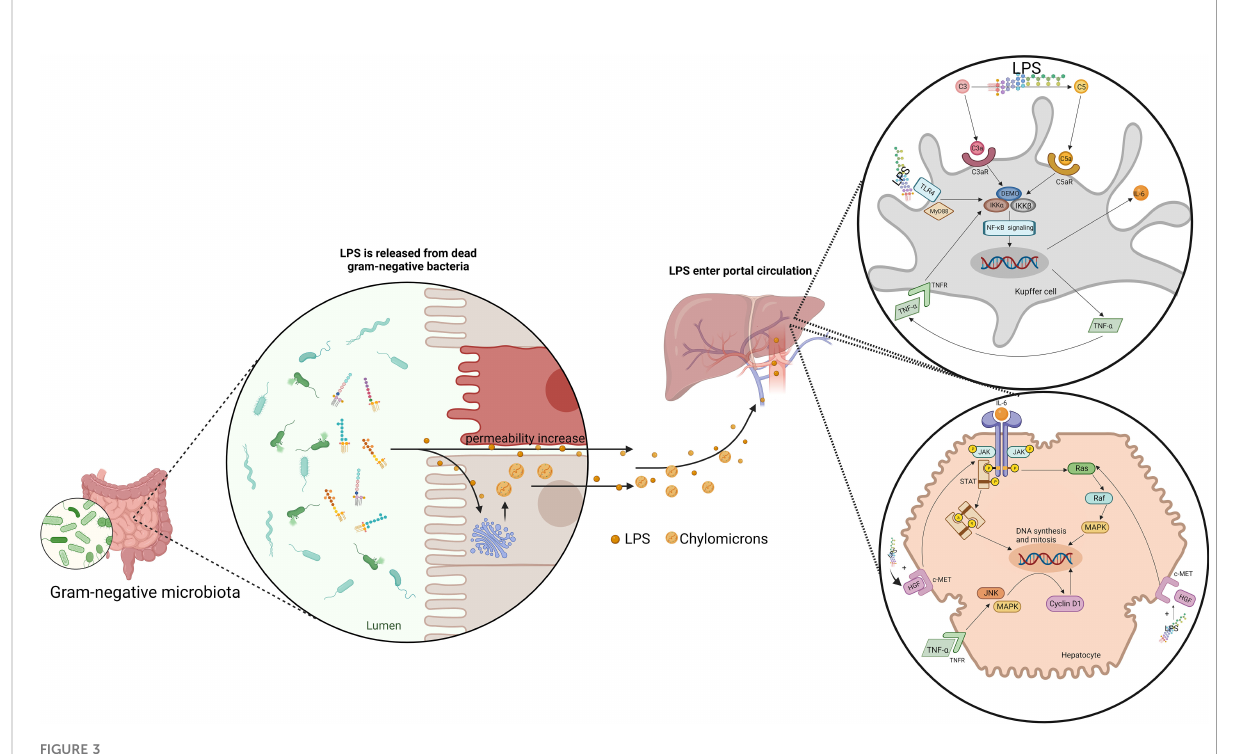
FIGURE 3 Gut-derived LPS translocates by chylomicrons and increase intestine permeability to promote liver regeneration. LPS induce the release of IL-6 and TNF- a in Kupffer cells through NF- k B signaling pathway. IL-6 promote the DNA synthesis and mitosis of hepatocytes by activating JAK/STAT pathway and Ras-Raf-MAPK pathway. TNF- a activate JNK and MAPK-ERK, inducing cyclin D1 expression. Besides, LPS can enhance the effect of HGF on